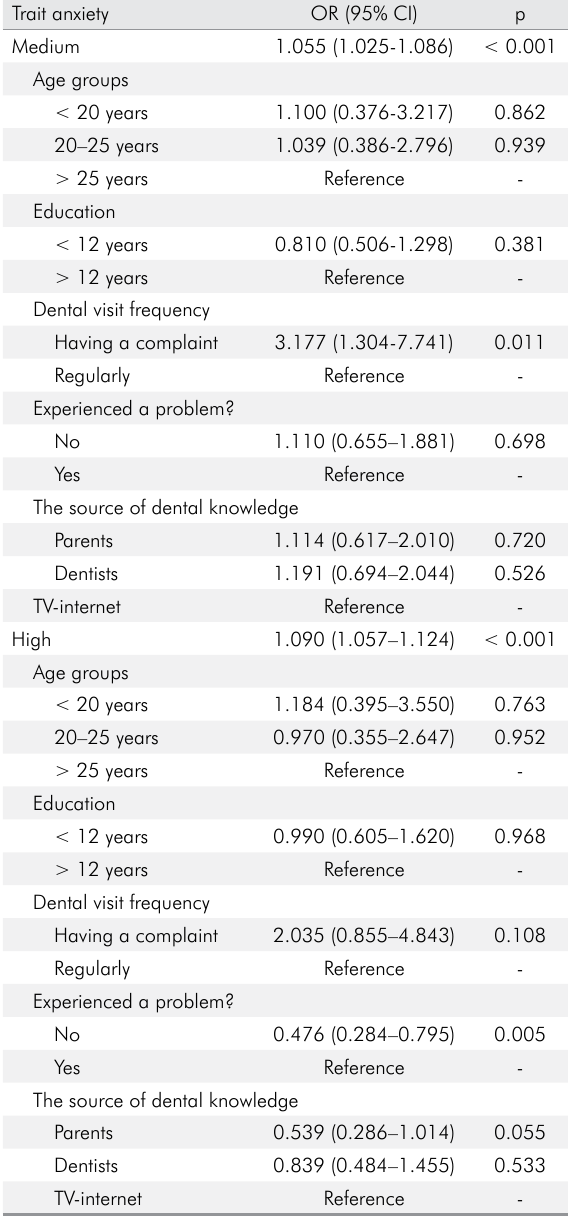
Table 4. Multivariate logistic regression analysis of the MDFS [Medium (36.6%, n = 184) or High dental fears (32.8%, n = 165) vs Low dental fear (30.6%, n =